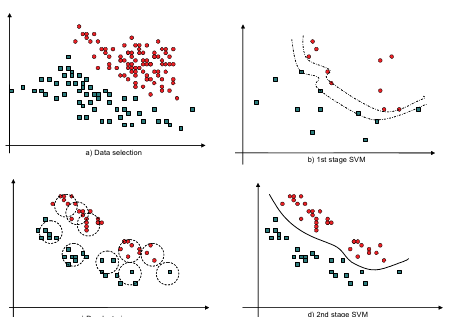
Figure 4. Two-stage classification via MEB clustering